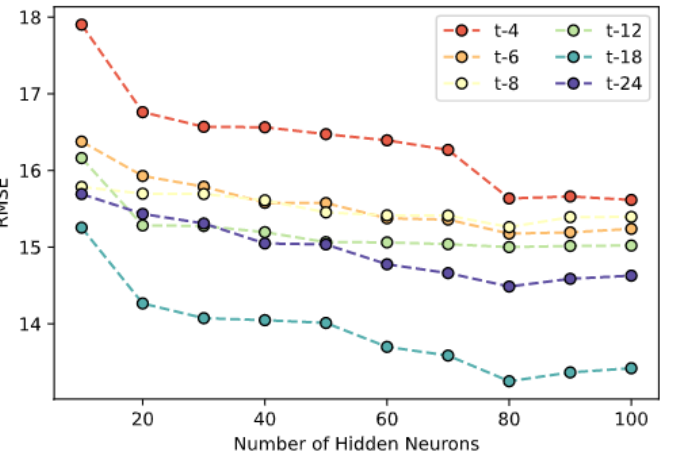
Figure 12. Influence of hidden neuron number and sliding window length on prediction results.